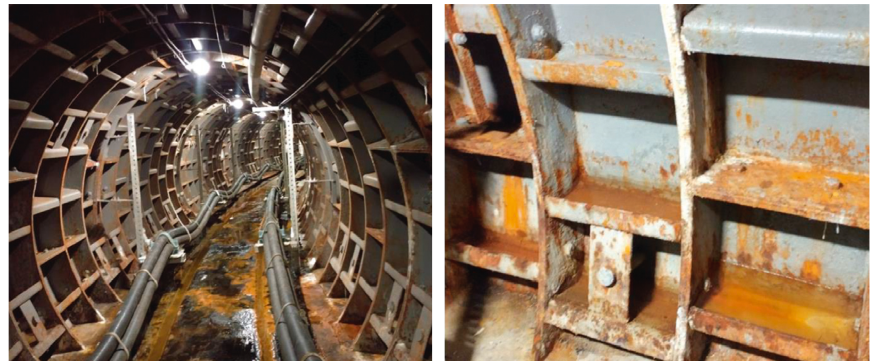
Figure 1: Corrosion of steel segments.